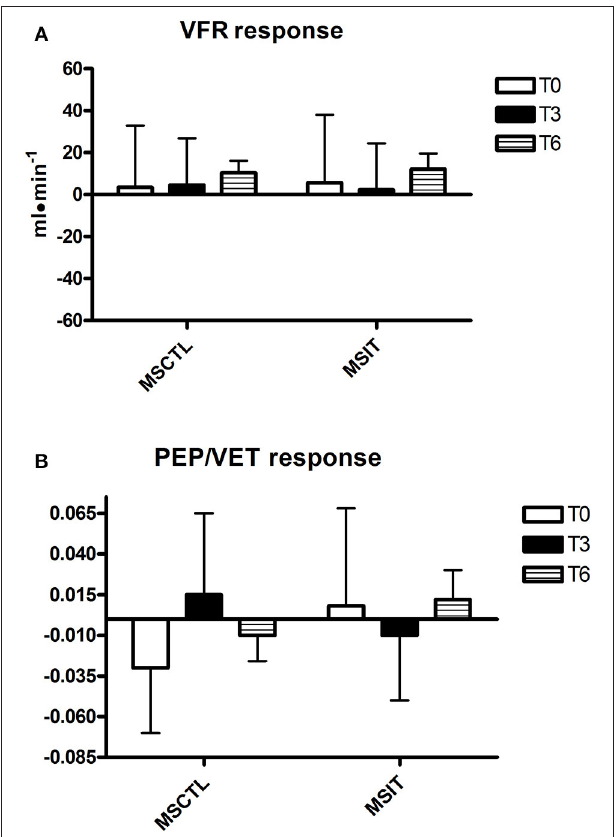
FIGURE 3 | Responses due to metaboreflex activation in VFR (A) and PEP/VET (B) at T0, T3, and T6, respectively. Groups are the MSCTL ( n = 10) and the MSIT ( n = 11). Values are mean ±